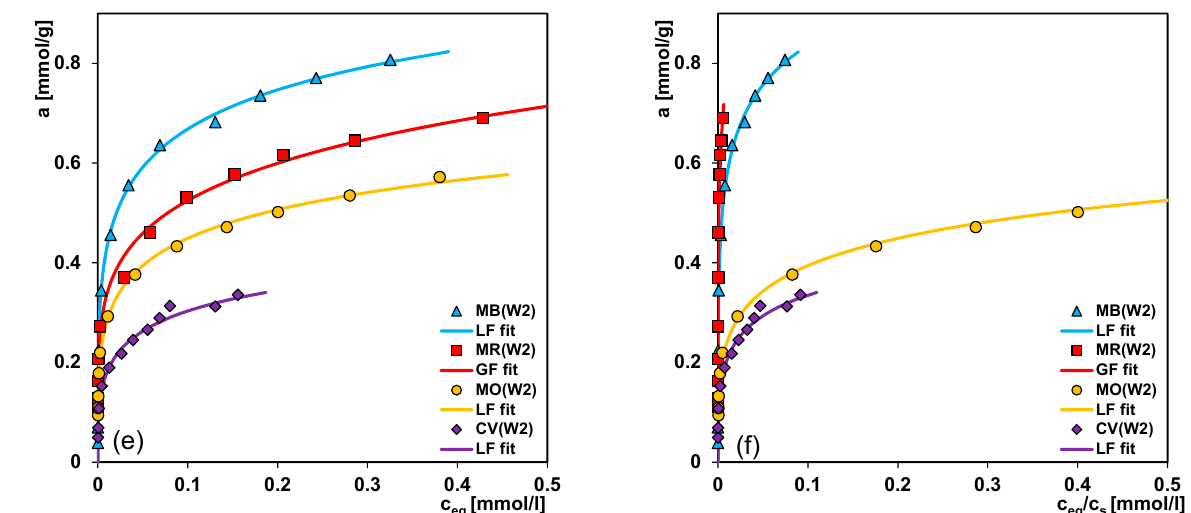
Figure 6. Comparison of the adsorption isotherms for dyes from various structure classes on the activated carbon RIAA ( a , b ); W1 ( c , d ) and W2 ( e , f ) in the standard and reduced coordinate systems.